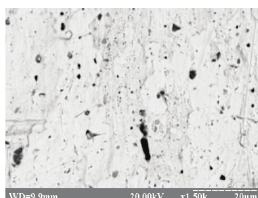
Figure 6. Guide vanes repair: a – blade dismantling place aft er metalworking; b – a blade aft er soldering